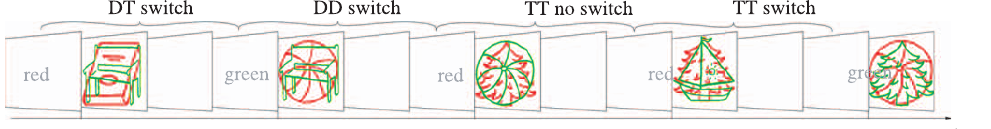
Figure 2. An example sequence of stimuli of Experiment 2. A trial begins with the display of a grey color word, followed by the actual stimuli. The fixation cross is omitted in the shown sequence for